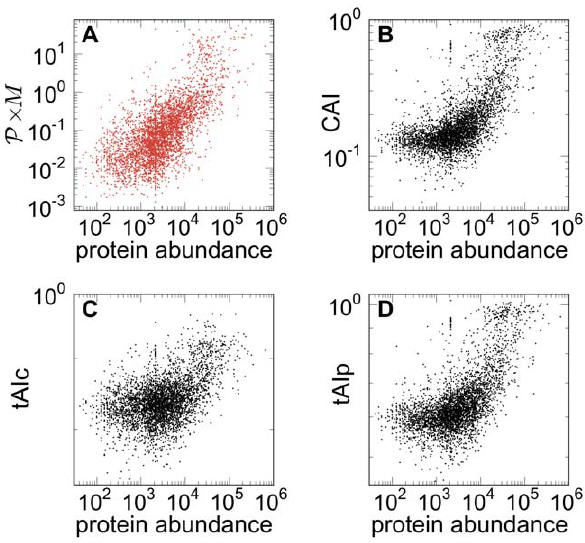
Figure 7. Scatter plots of different estimators of protein production rates. ( A ) P | M versus abundance of proteins. The mRNA abundances are from [30] and the experimentally measured protein levels from [51]. The plot shows a clear correlation between the model prediction of the amount of proteins in the cell and the experimental values. ( B ) CAI from [30] versus protein abundance. ( C ) and ( D ) show different variants of the tRNA adaptation index, tAIc and tAIp from [30], vs protein abundance. Our approach yields a better correlation between the predicted and measured protein abundance.